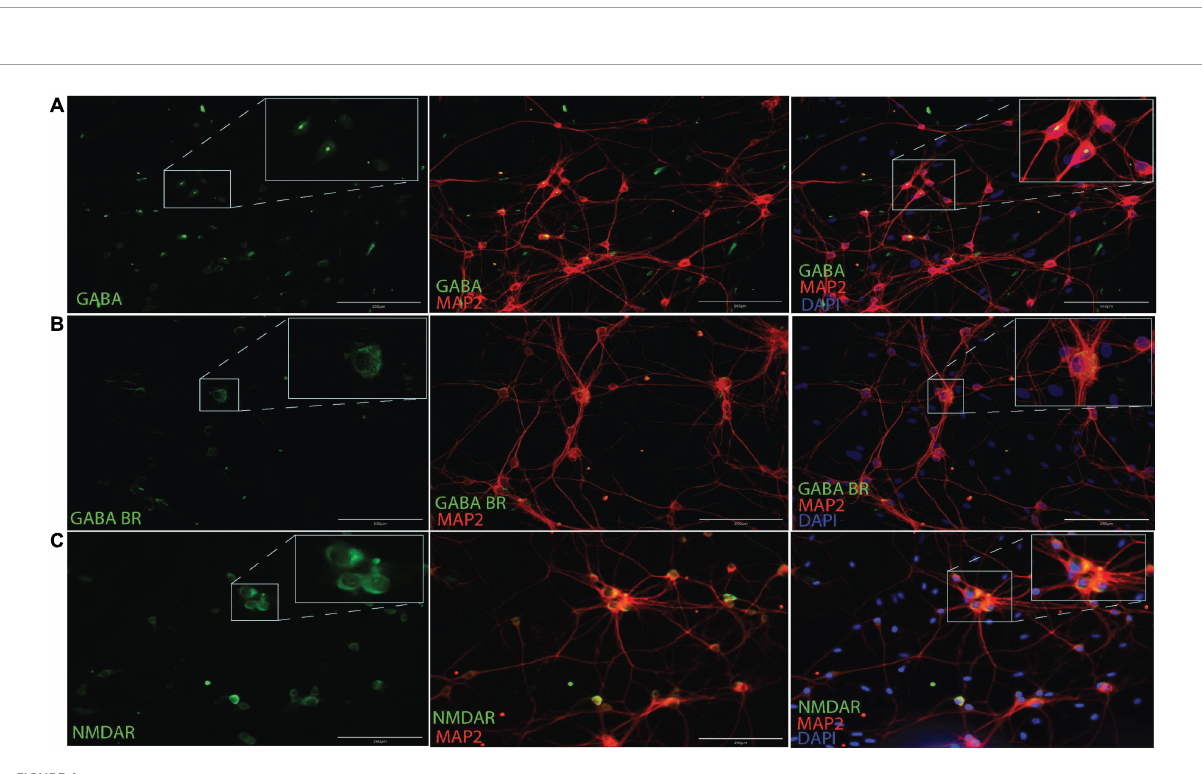
Frontiers in Neural Circuits